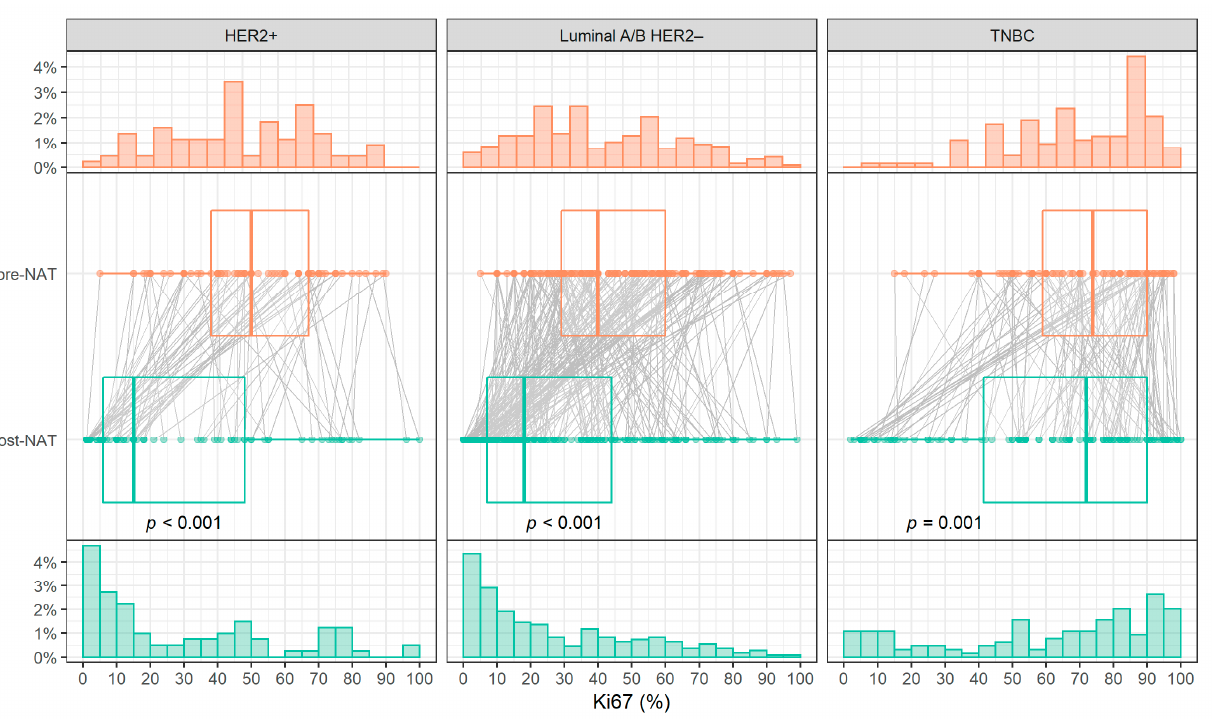
Figure 3. Histograms of Ki-67 pre- (top) and post-NAT (bottom) levels and comparison of Ki-67 levels (center). Abbreviations: TNBC, triple-negative breast cancer; HER2, human epidermal growth factor receptor 2; NAT, neoadjuvant